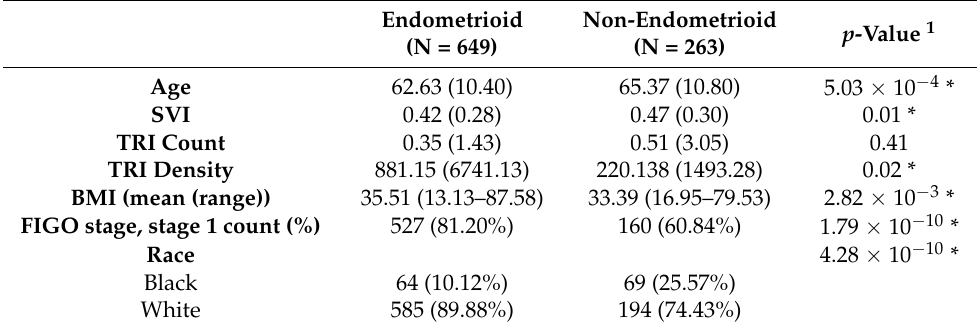
Table 1. Demographics of study population by histotype, mean